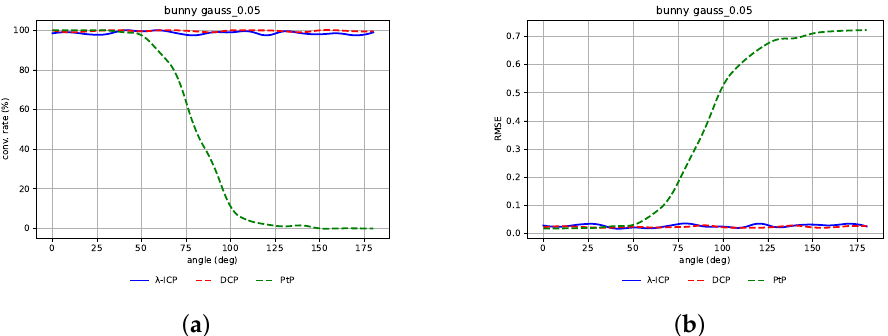
Figure 8. ( a ) Convergence rate of λ -ICP (blue), DCP (red), PtP (green) algorithms for Stanford Bunny with Gaussian noise, σ = 0.05; ( b ) mean RMSE (for transformation matrices) of λ -ICP (blue), DCP (red), PtP (green) algorithms for Stanford Bunny with Gaussian noise, σ = 0.05.